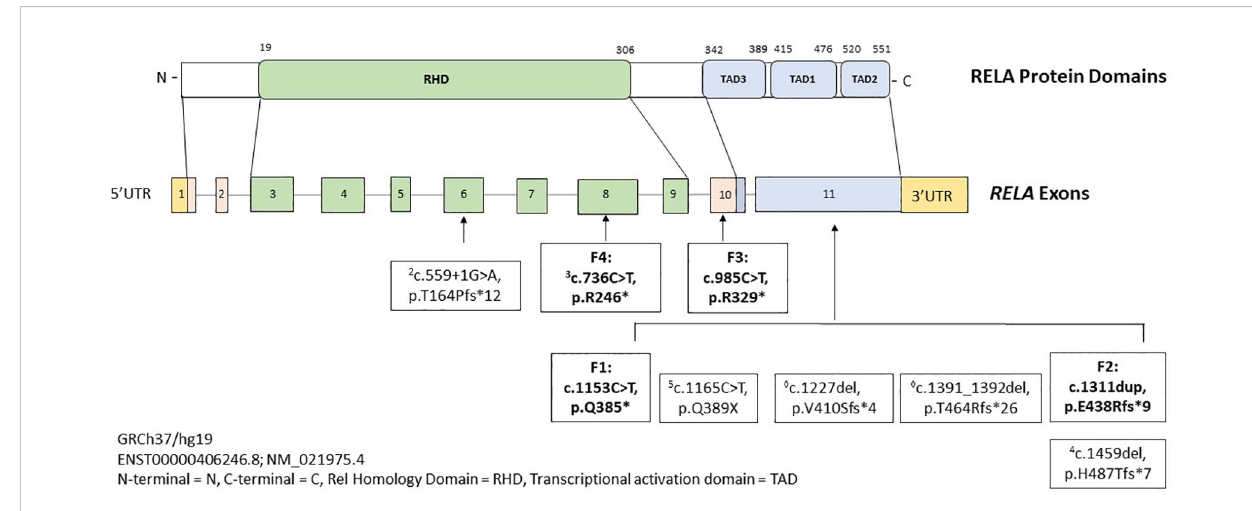
FIGURE 3 Schematic showing domain structure and functional motifs of the transcription factor p65 protein with summary of pathogenic/likely pathogenic variants in RELA gene. Mutations reported in literature are depicted in regular font and in bold are mutations identi fi ed in our four families. Superscripted numbers correspond to the original cases listed in References.